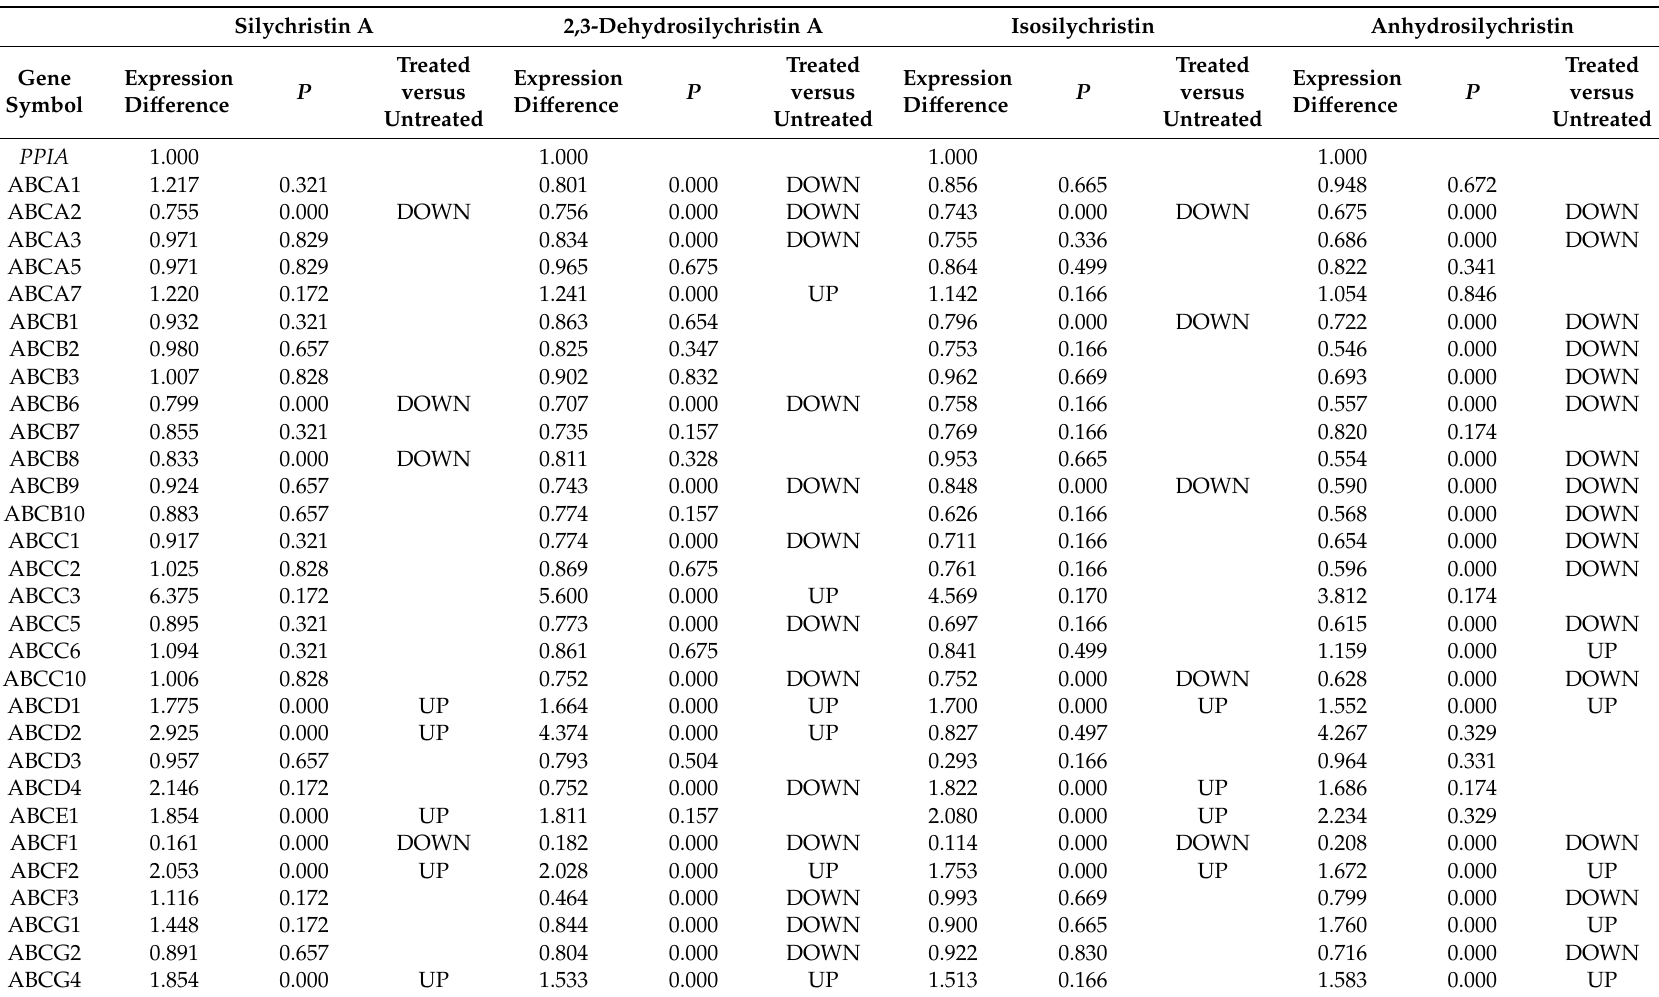
Table A2. E ff ect of silychristin A and its derivatives [10 µ M] on ABC superfamily genes expression profiles in HOC / ADR cell